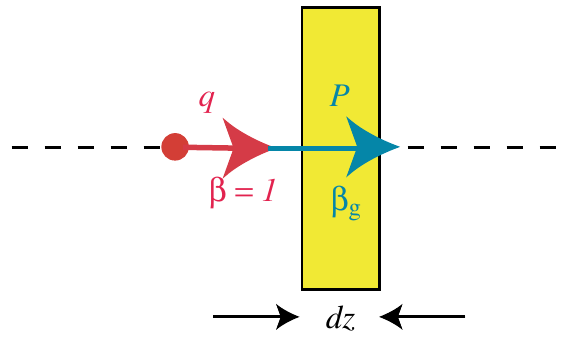
FIG. 1. (Color) A relativistic, pointlike bunch with charge q passing through at infinitesimal length dz of accelerator. P is power in the accelerating mode, which has group velocity (cid:9) (cid:1) 1 and phase velocity (cid:9) phase